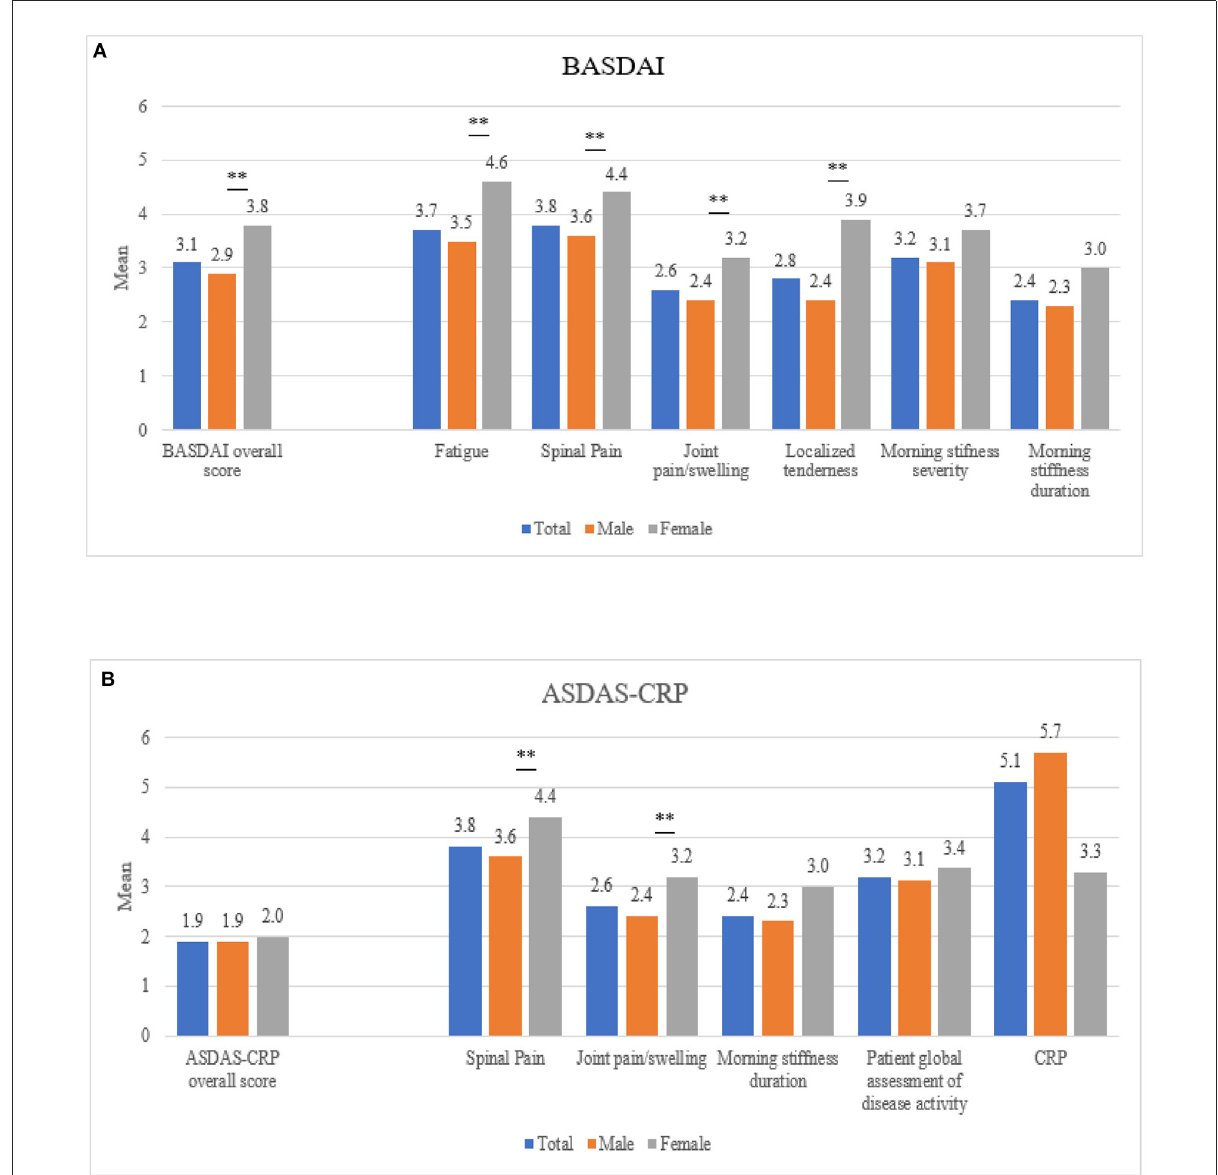
FIGURE1 Mean disease activity scores by gender, measured by (A) BASDAI and (B) ASDAS-CRP. BASDAI, Bath Ankylosing Spondylitis Disease Activity Index; ASDAS-CRP, Ankylosing Spondylitis Disease Activity Score with CRP. The left values on x-axis denotes the mean index score and values on the right of the x-axis display values for each individual component of the indices. ** p <